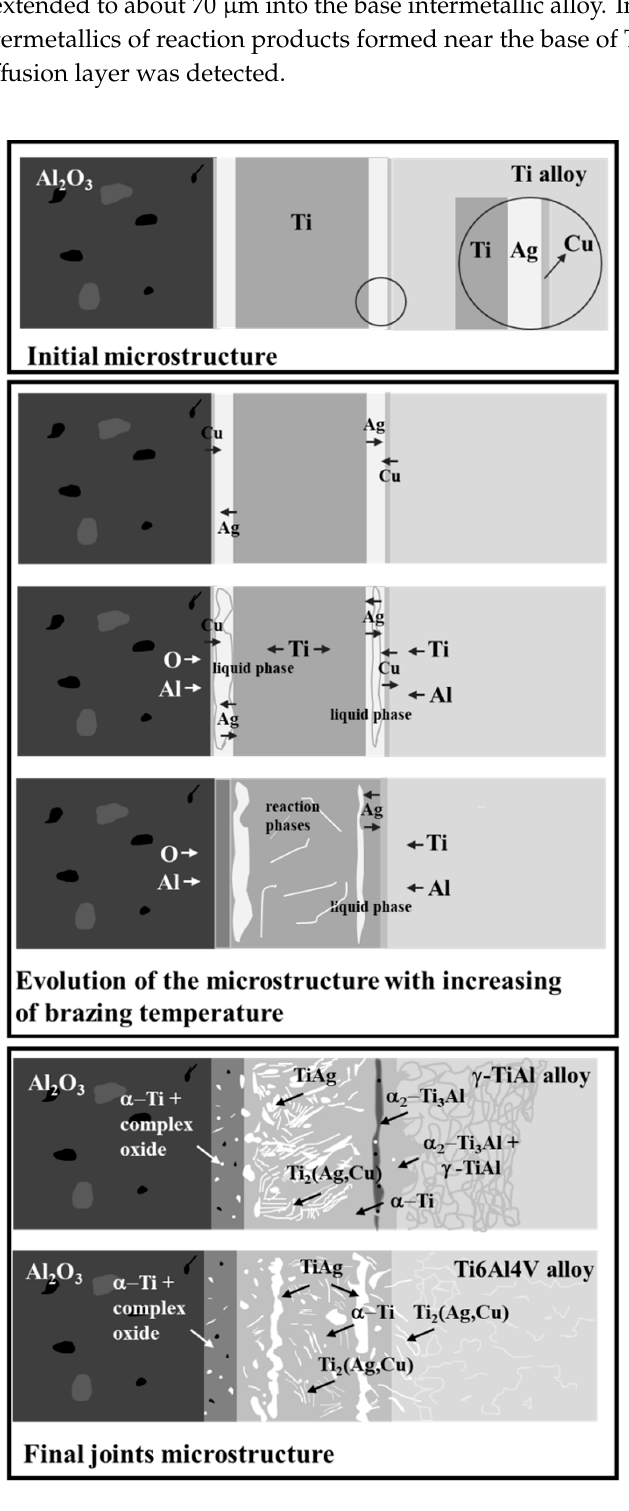
Figure 8. Schematic illustration of the mechanism for the evolution of microstructure in the interfaces obtained in this study.